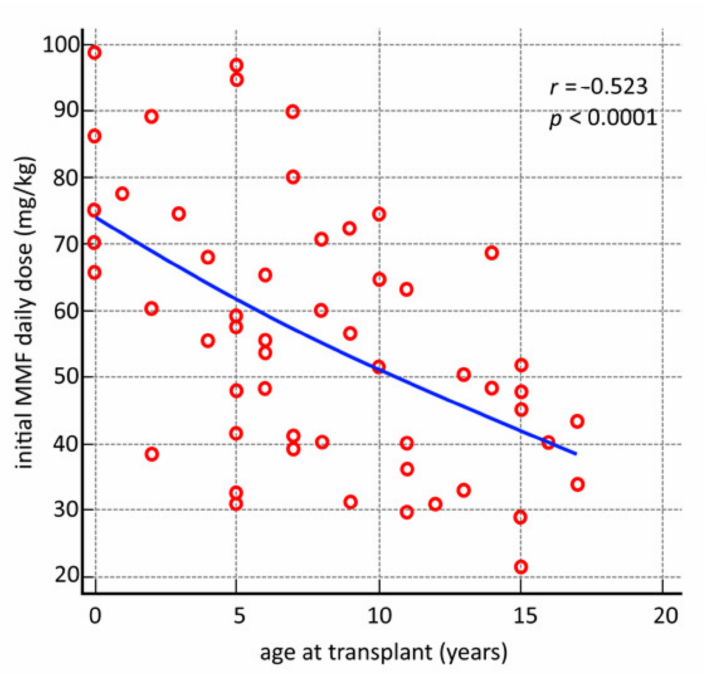
Figure 5. Correlation between initial mycophenolate mofetil (MMF) daily dose and age of trans- plant